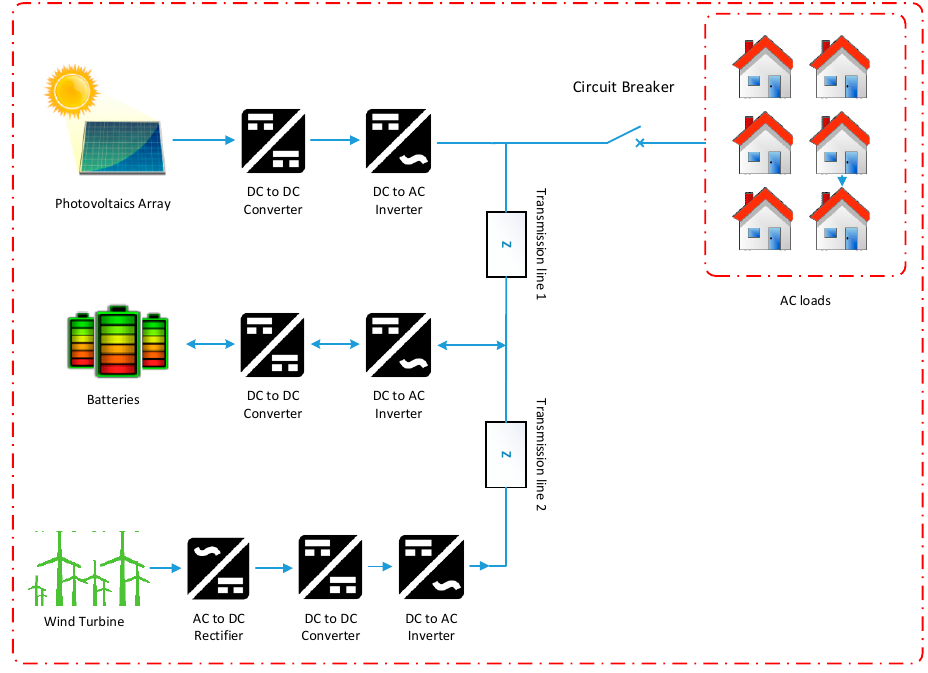
Figure 1. The proposed system structure.